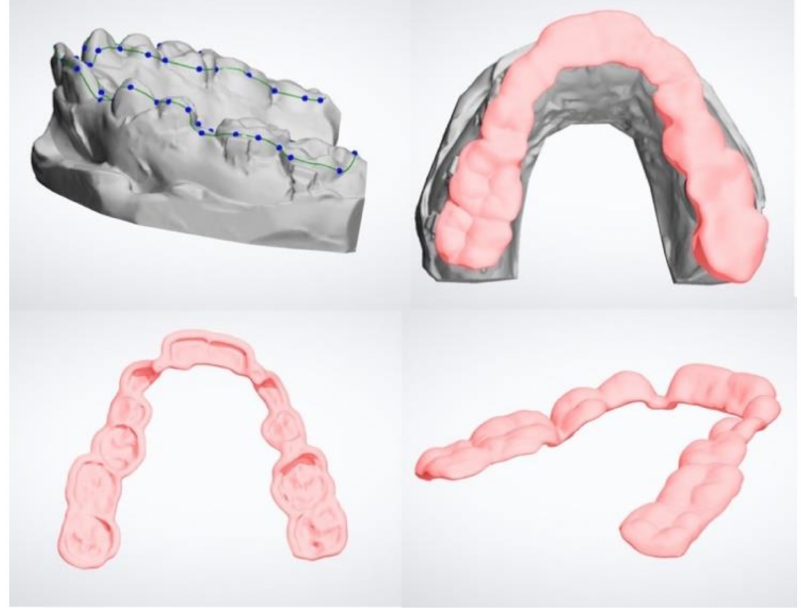
Figure 1. Digital design (CAD) of surgical splint: definition of spline curve and generation of 3D model on the upper arch.